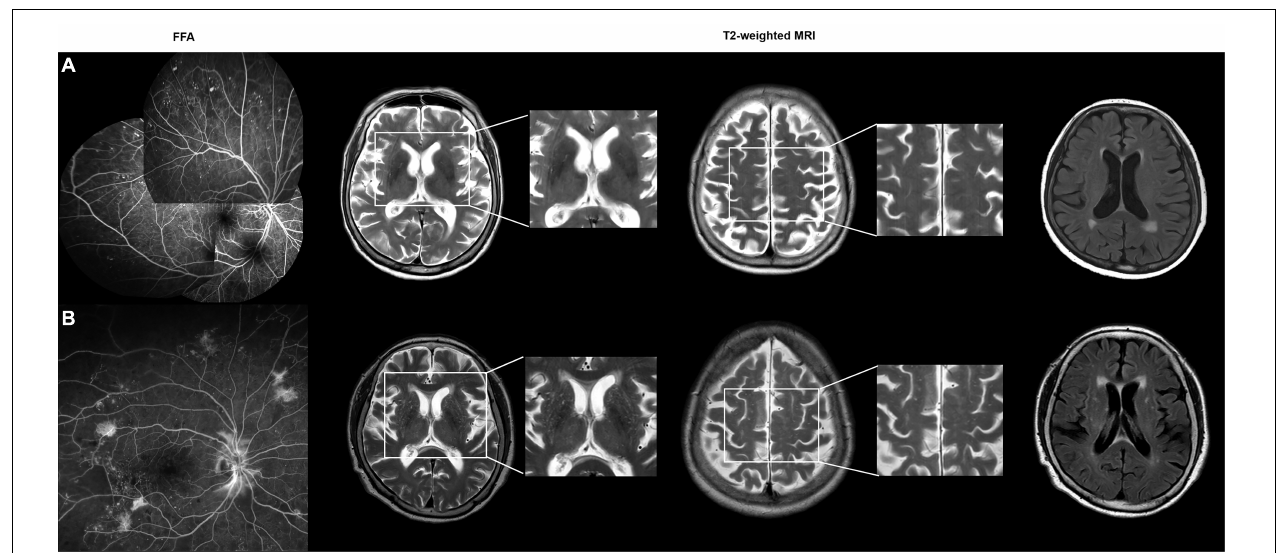
FIGURE 1 | (A) A 83-year-old female with non-proliferative diabetic retinopathy (DR). Patchy areas of capillary dropout with microaneurysms were observed on a montage fundus fluorescein angiography (FFA) image. The axial T2-weighted MRI images show grade 0 perivascular space in the basal ganglia (BG-PVS). On fluid-attenuated inversion recovery (FLAIR) images, the total Fazekas score was 2. The total cerebral small vessel disease (SVD) score was 0. (B) A 73-year-old female with proliferative DR. Wide-field FFA image shows the presence of neovascularizations elsewhere around the wider areas of non-perfusion. The axial T2-weighted images show grade 4 BG-PVS. On FLAIR images, the total Fazekas score was 3. The total cerebral SVD score was 1.